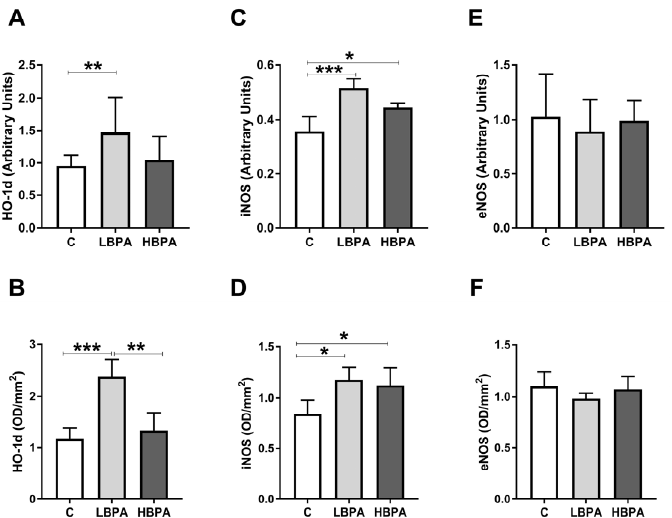
Figure 4. Oxidative stress intermediaries in livers from lactating dams after exposure to different doses of BPA. mRNA and protein expressions of HO-1d (heme oxygenase 1) ( A , B ); iNOS (inducible nitric oxide synthase) ( C , D ); and eNOS (endothelial nitric oxide synthase) ( E , F ). Data represent mean ± SD. For mRNA, n = 8 control dams; n = 8 LBPA dams; n = 6 HBPA dams (three replicates for each gene). For protein, n = 5 rats per experimental group. Data represent mean ± SD. Statistical significance was determined by one-way ANOVA. * p < 0.05; ** p < 0.01; *** p < 0.001.